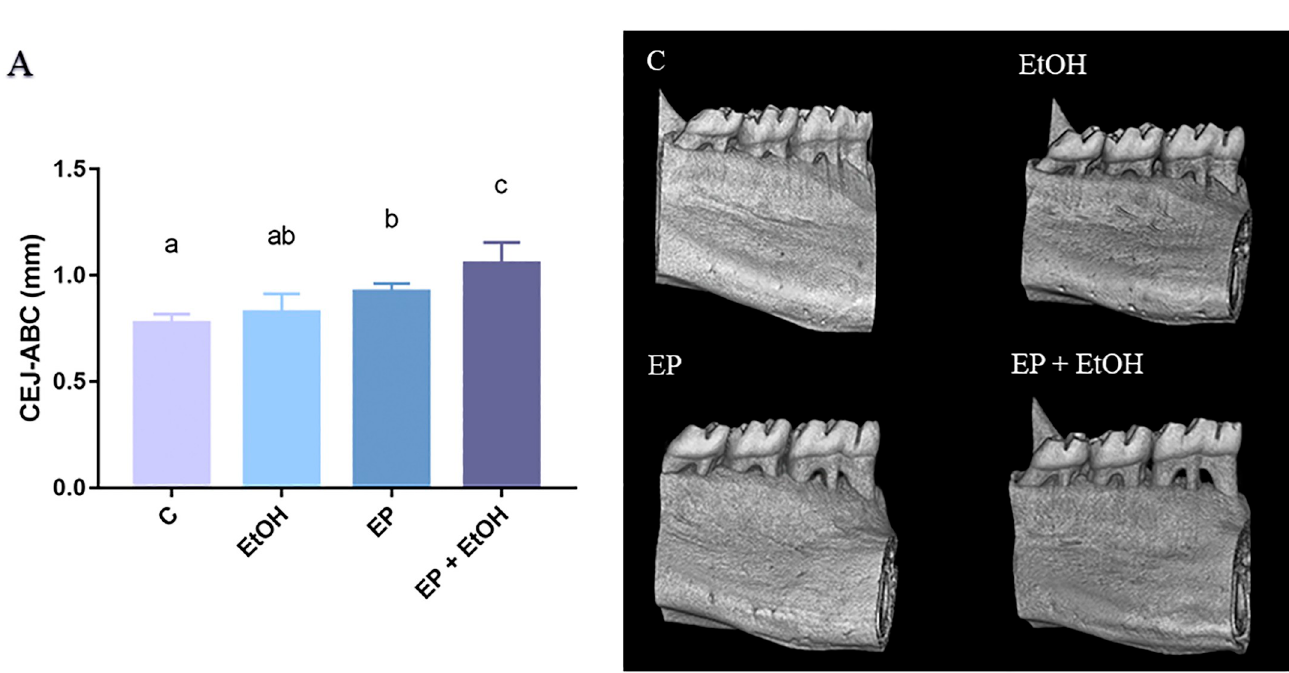
Fig 3. Cementum-enamel junction to alveolar bone crest (CEJ-ABC) distance (mm) in all experimental groups. (A) Results are expressed as mean ± standard error of the distance of cementum-enamel junction to alveolar bone crest in mm. On the right panel, there is the 3D reconstruction of hemi-mandibles of the (C) Control group; (EtOH) Ethanol binge drinking group; (EP) Experimental periodontitis group and (EP + EtOH) Experimental periodontitis and Ethanol group. EP +EtOH group presented the highest alveolar bone loss identified by the greatest measure of the ACJ-ABC distance. Same letters indicate no significant differences between groups (P < 0.05, ANOVA followed by Tukey post hoc test).